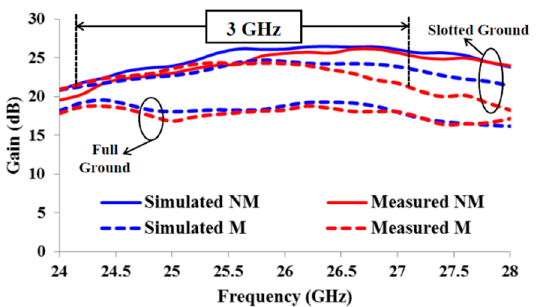
Figure 10. Gain versus frequency response for vertical polarization of asymmetric patch element reflectarray with and without embedded ground slots (NM = Non-Mirror and M = Mirror element orientation).